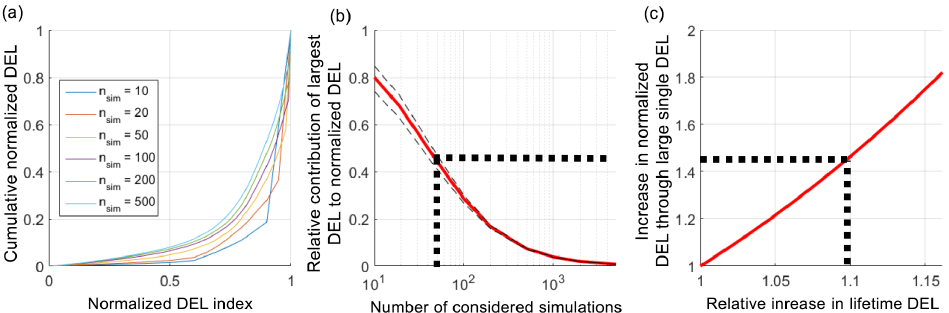
) for different numbers of considered simulations, exemplary results for one Figure 14. Cumulative normalized DEL contribution ( C ∗ DE ,i sample (a) , contribution of the largest DEL to the normalized DEL with increasing number of considered simulations, showing median, 10th and 90th percentiles (b) , and impact of increase in the normalized DEL on lifetime DEL (c) . Plots show results for tower base fore– aft bending moment. Dotted lines indicate connection between center and right plot. Normalized DEL index used in the left plot to allow showing varying number of